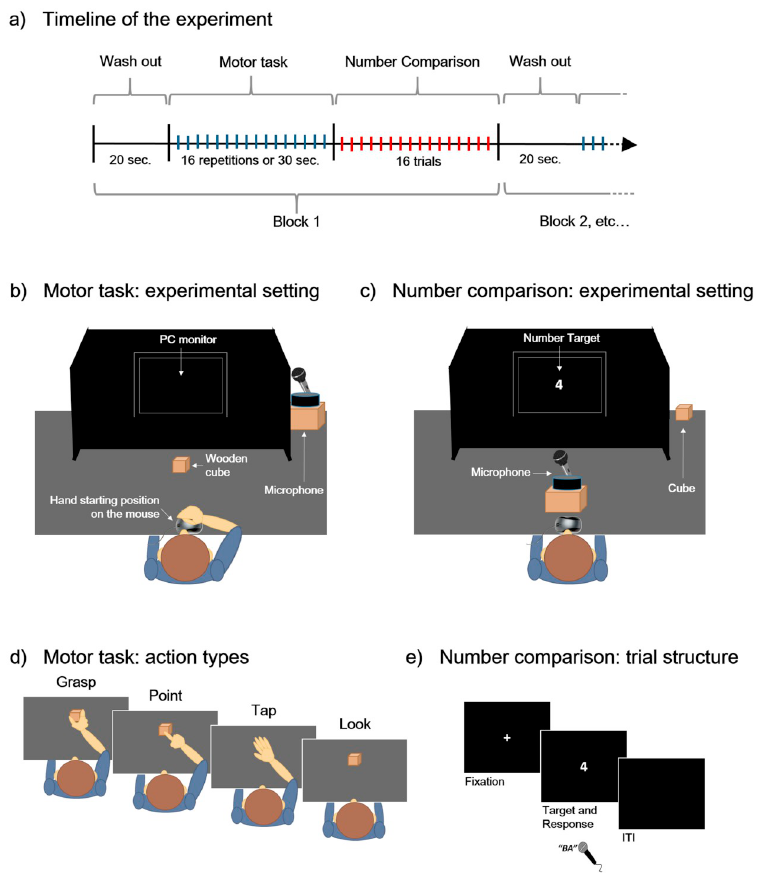
Fig 1. Graphical illustration of the experimental setup, see main text for details. Panel a. Timeline of the experiment. Panel b. Experimental setting during the hand motor task. Panel c. Experimental setting during number comparison. Panel d. Illustration of the four conditions of the motor task. Panel e. Schematic illustration of the trial structure in number comparison.